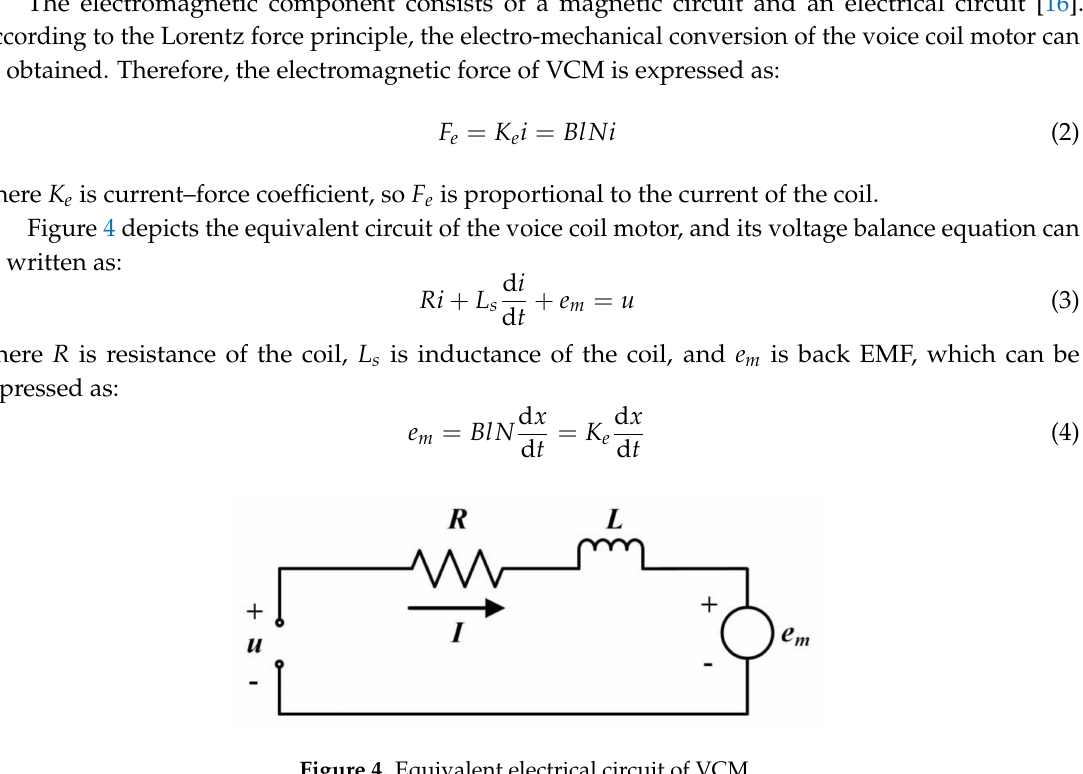
Figure 4. Equivalent electrical circuit of